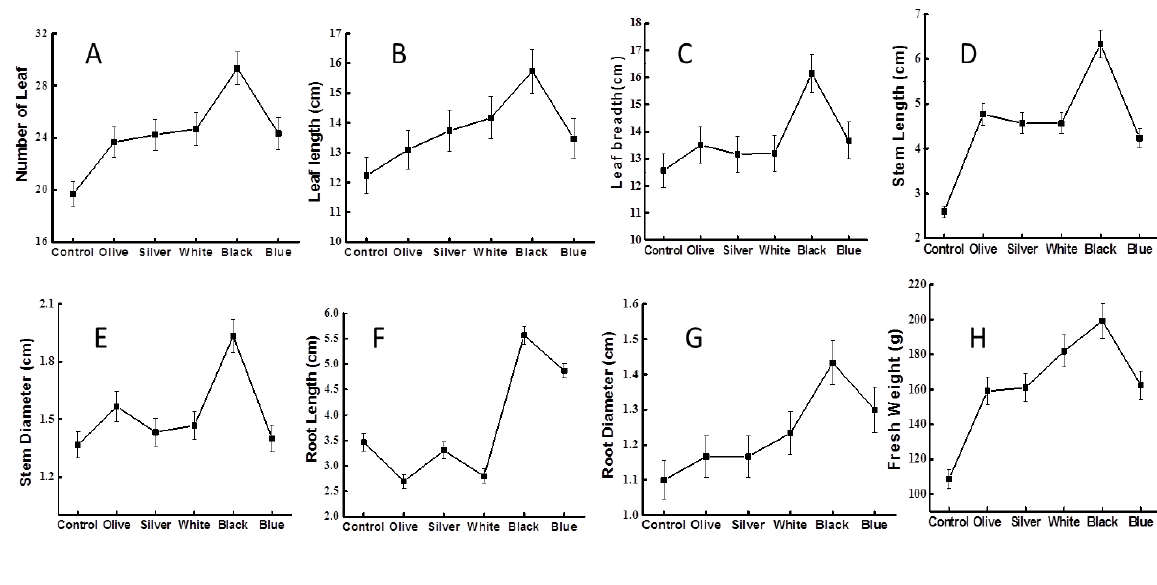
Fig. 2. Effects of different types of plastic films on growth and yield parameters in lettuce. Each line graph represents a mean value of three independent experiments and the vertical bars indicate SE (n =